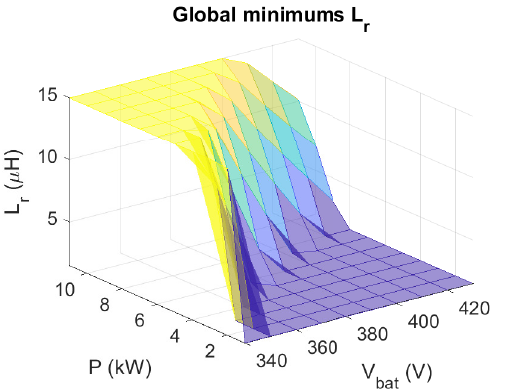
Figure 13. Global minimums of L r with respect to battery voltage and power variation.